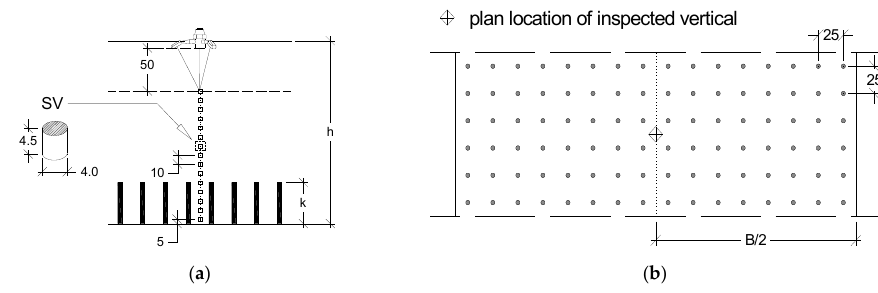
Figure 2. ( a ) Position of measurement stations and geometry of sampling volume. ( b ) Location of inspected vertical within the cylinder array.